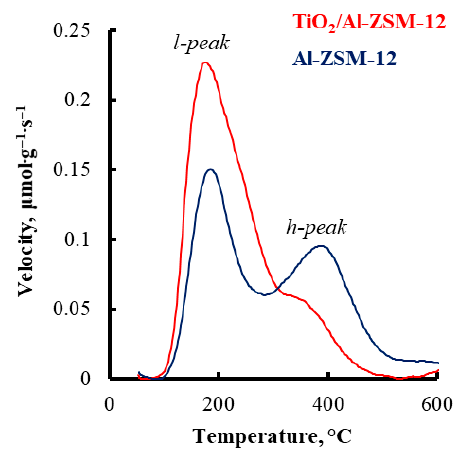
Figure 7. NH 3 –TPD synthesized zeolites. Table 2. Acid characteristics of synthesized zeolites.